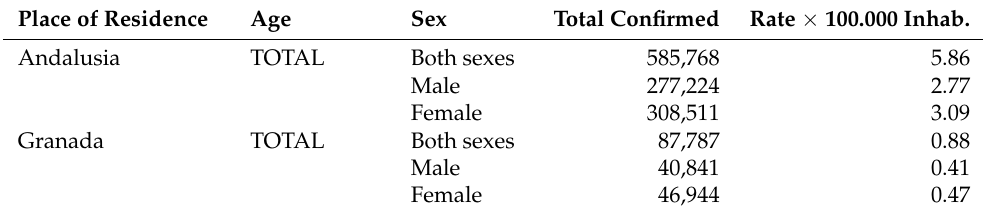
Table 2. Confirmed cases of COVID-19 in Andalusia and Granada province. Source: IECA portal on COVID-19 in Andalusia. Prepared by the